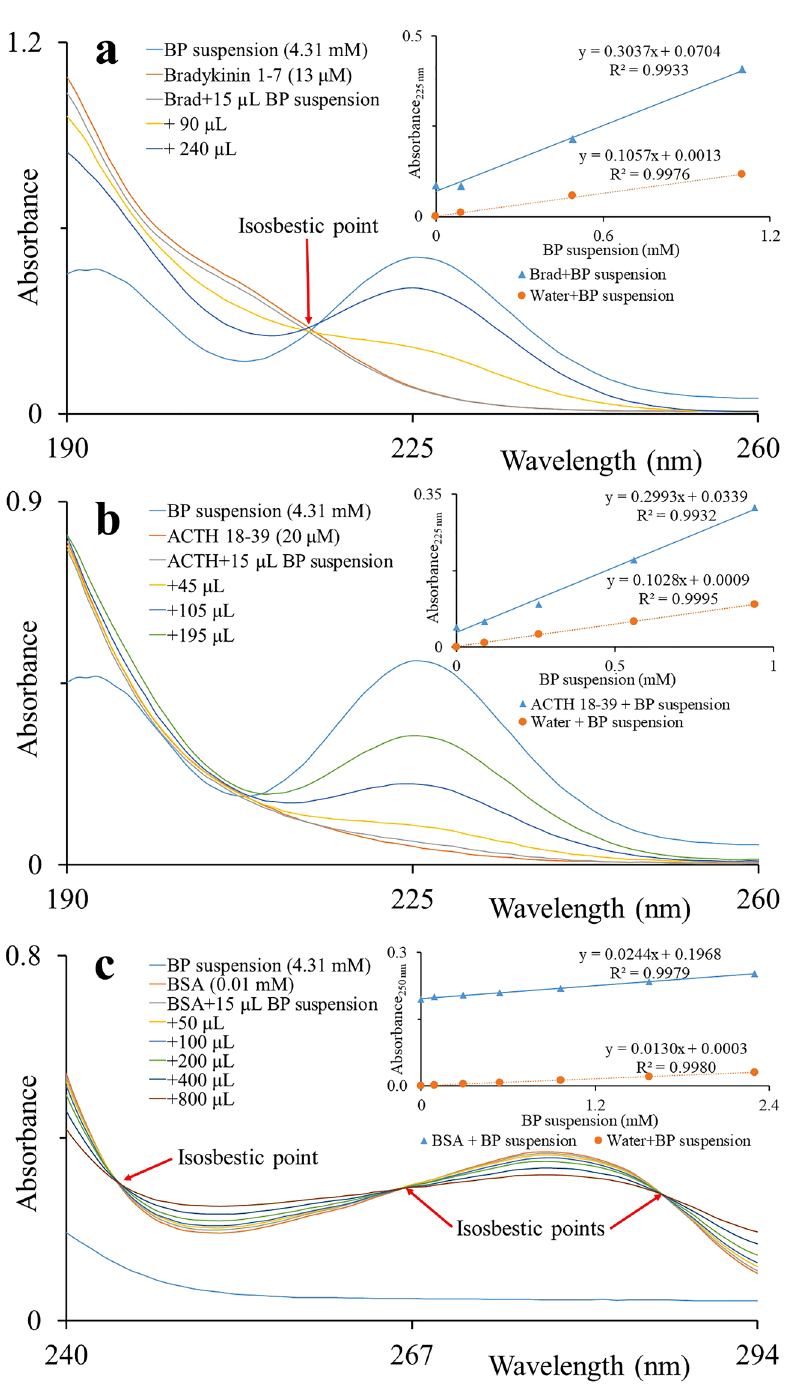
Figure 6. Black phosphorus interacts with peptides. Water solutions of bradykinin fragment [1–7], adrenocorticotrophic hormone fragment [18–39] and bovine serum albumin were titrated with BP water suspension. Absorption spectra were recorded. ( a ) bradykinin [1–7], ( b ) ACTH [18–39], and ( c ) BSA solutions. The inset shows the absorbance at 225 and 250 nm wavelengths plotted against the concentration of BP fine particles in the respective analyte solution (blue) and in water